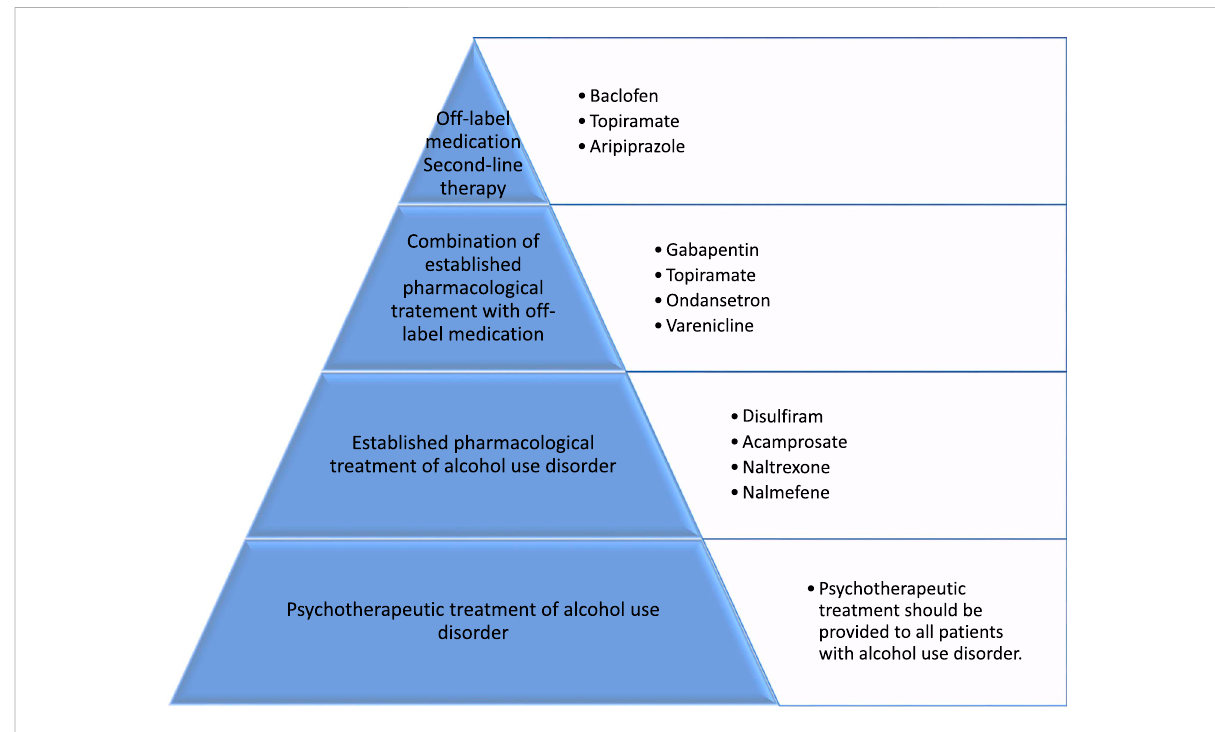
FIGURE 1 Pyramid of treatment in alcohol use